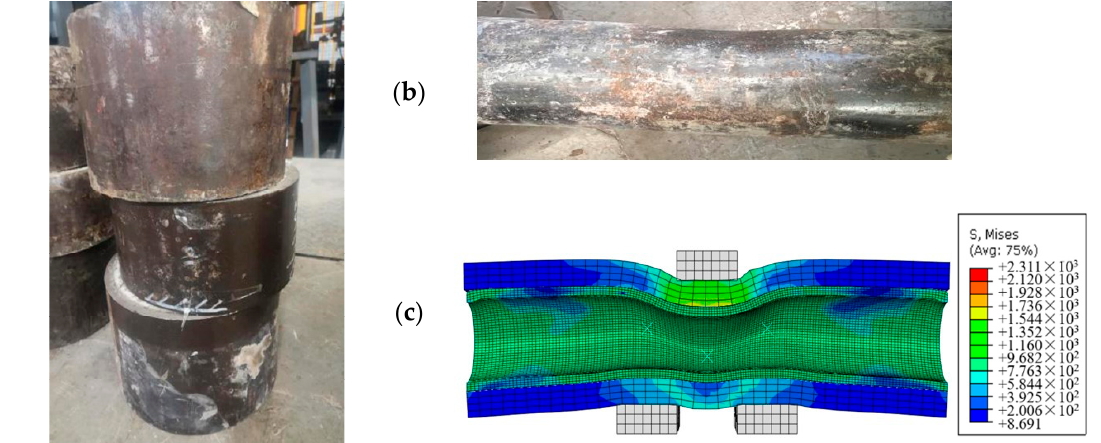
Figure 9. Deformation morphology of casing–cement sheath after 40 mm shear deformation: ( a ) casing–cement sheath after test; ( b ) casing after test; ( c ) equivalent stress distribution